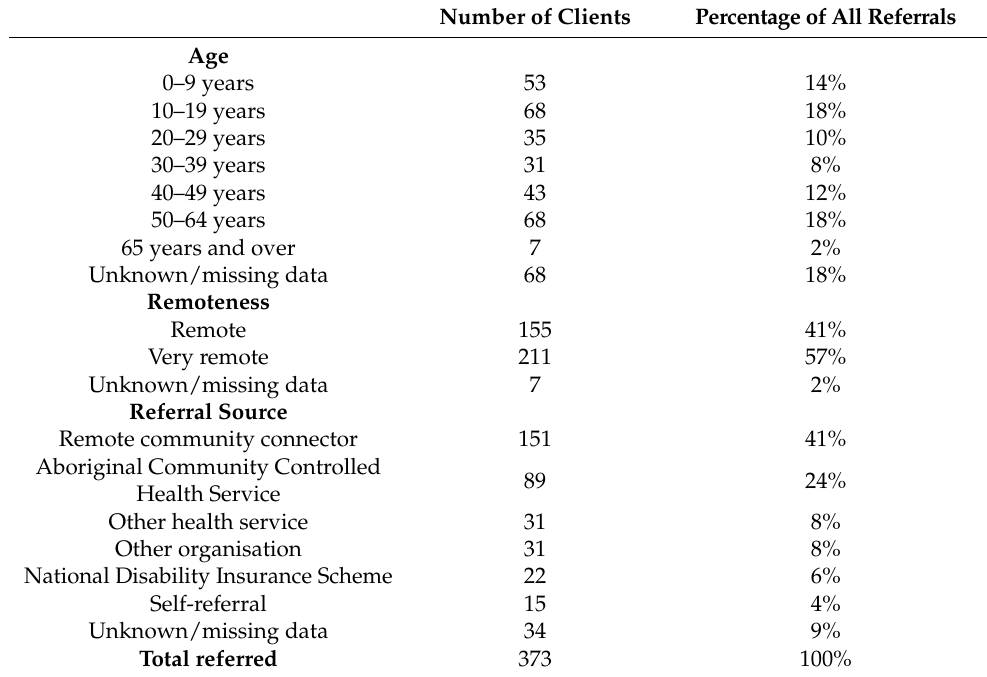
Table 1. Characteristics of those referred to an EACP in the Kimberley region 31 October 2019